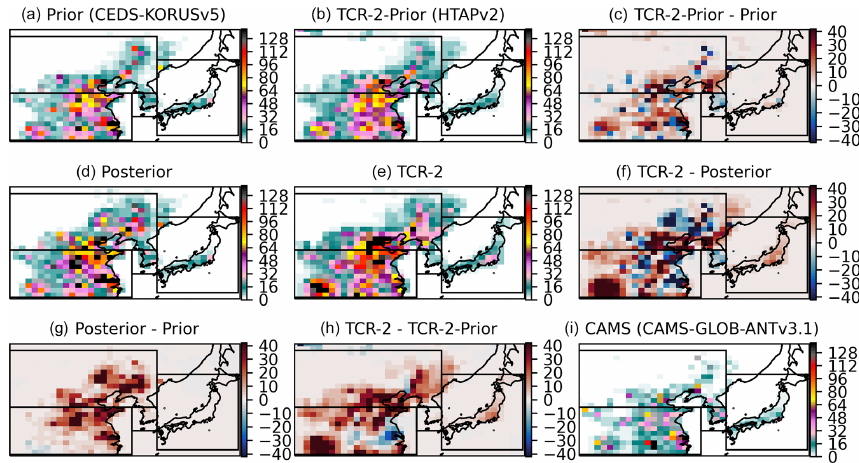
Figure 5. Emissions flux for May 2016 in megagrams of CO per month. Prior ( a , CEDS-KORUS v5), TCR-2 prior ( b , HTAP v2), and the difference between the two priors ( c , TCR-2 prior – prior). Panels (d–f) show the posterior ( d , estimated by DART/CAM-Chem), the TCR-2 (e) , and the difference between the two posteriors. Panels (g–i) show the emissions increments, the difference between the posterior and the prior (g) , and the difference between the TCR-2 and TCR-2 prior (h) . The CAMS emissions are shown in panel (i) . Table 4. Comparison of CO (ppbv) measured aboard the DC-8 and model simulation for all altitudes. Statistical indicators are calculated